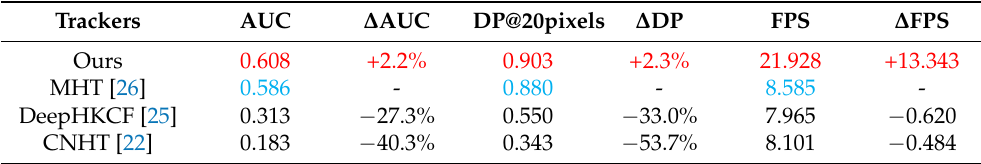
Table 5. Tracking performance comparison with hyperspectral trackers. The best two results are marked with red and